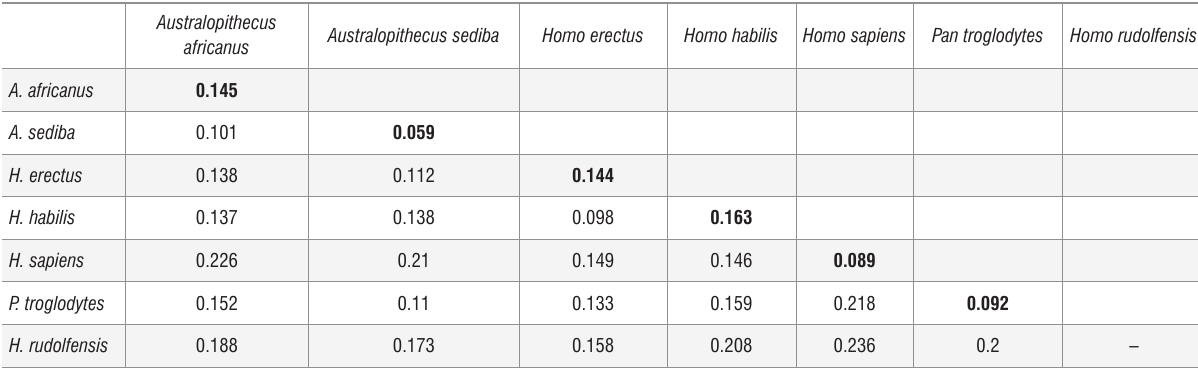
Average Procrustes chord distances within taxa (on diagonal) and among taxa (off diagonal) Australopithecus Australopithecus sediba Homo erectus Homo habilis Homo sapiens Pan troglodytes Homo africanus